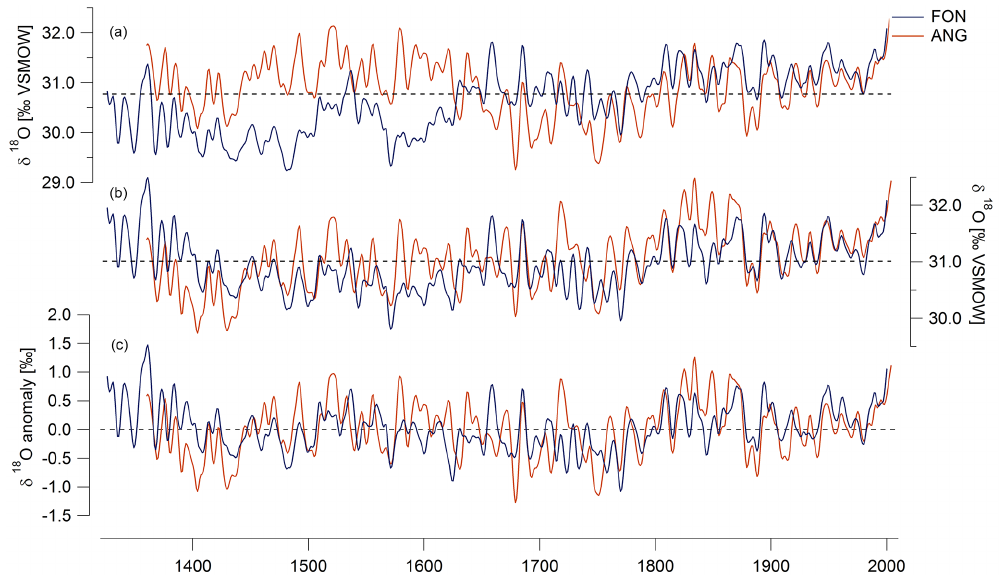
Figure 5. Cohort offset correction for cellulose δ 18 O chronologies from Fontainebleau (FON) and Angoulême (ANG) (low-pass filtered data). Different methods were used in order to combine overlapping tree cohorts to a site chronology: (a) raw values; (b) correction of the offset between cohorts (see Fig. 4) by adjusting the mean of the older cohorts to the mean of the respective younger cohorts; (c) all cohorts were normalized by subtracting the mean of each cohort from the respective δ 18 O values before combining them. In each case, an average weighted by the number of trees was calculated for overlap periods between cohorts.